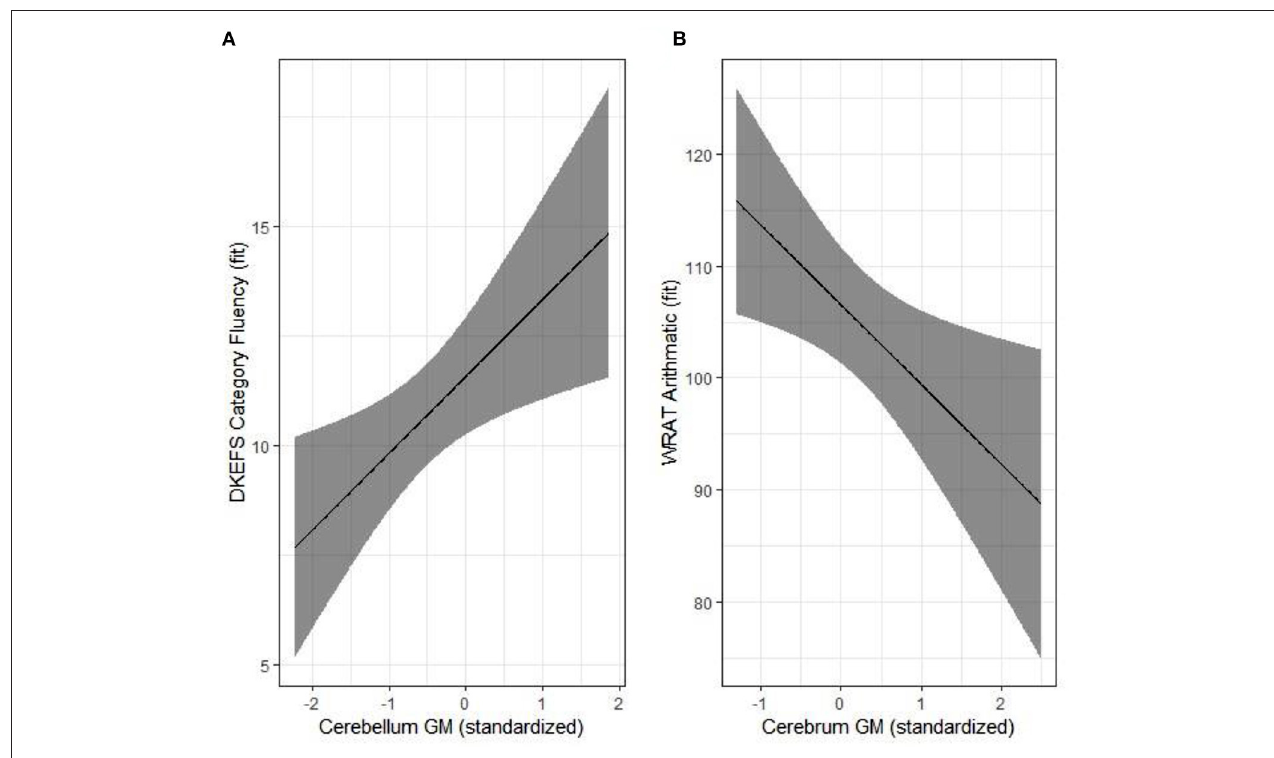
FIGURE 2 | Structure-function relationships in the pediatric chronic kidney disease (CKD) group. Significant associations are illustrated for cerebellum gray matter and category fluency (A) and cerebrum gray matter and arithmetic (B) . Results were adjusted for age, parental SES and maternal education. Reproduced with permission from Solomon et al. (